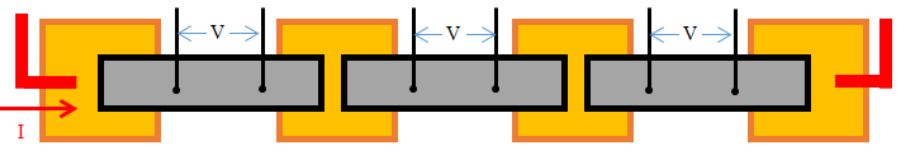
Figure 16. Schematic of samples 4, 10, and 12 in series for impact